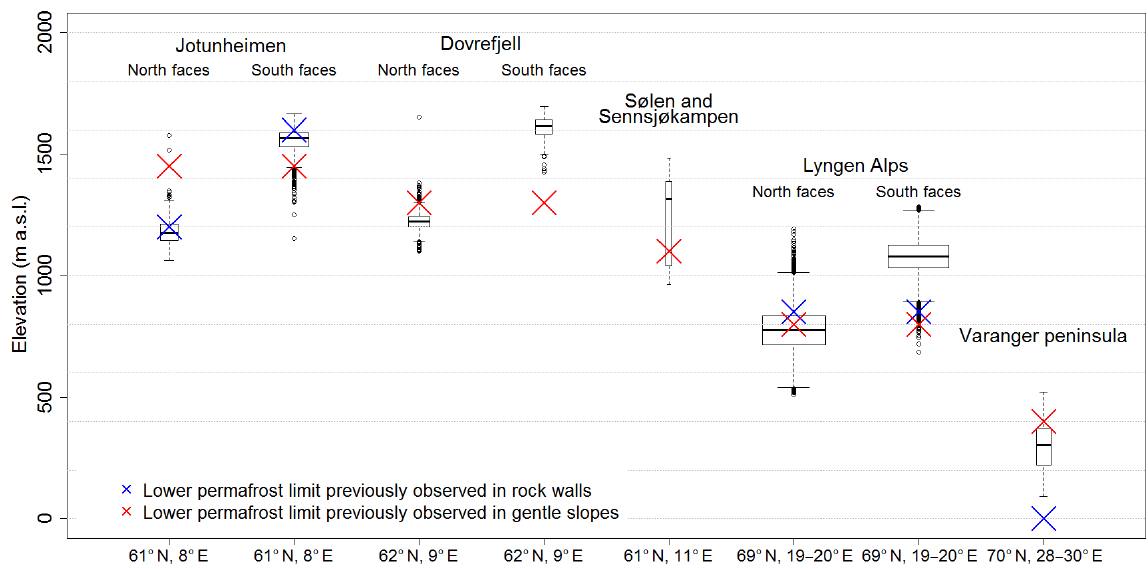
Figure 13. Comparison of steep slope permafrost distribution in specific regions with estimations from previous studies (Hipp et al., 2014; Isaksen et al., 2002, 2008, 2011; Farbrot et al., 2011, 2013; Sollid et al., 2003; Westermann et al., 2013; Heggem et al., 2005; Steiger et al., 2016; Gisnås et al., 2017; Borge et al., 2017). The width of the boxes is proportional to the square roots of the number of observations in the respective